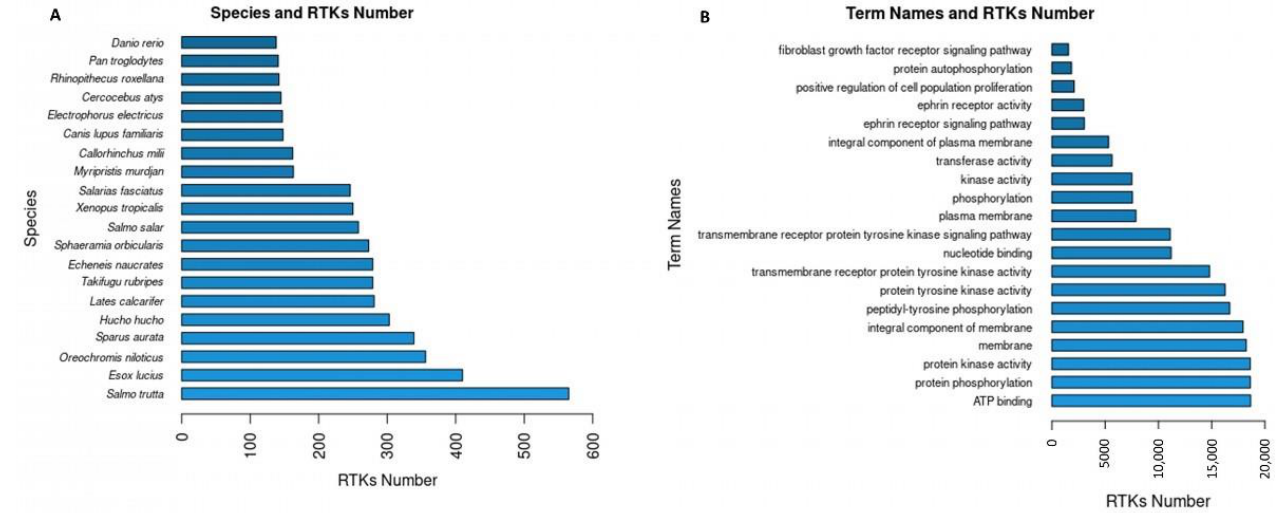
Figure 3. ( A ) The 20 most abundant in RTKs species based on the predictions of RTK-PRED and the NCBI taxonomy database; ( B ) the term names of the 20 GO IDs corresponded to the most RTKs.